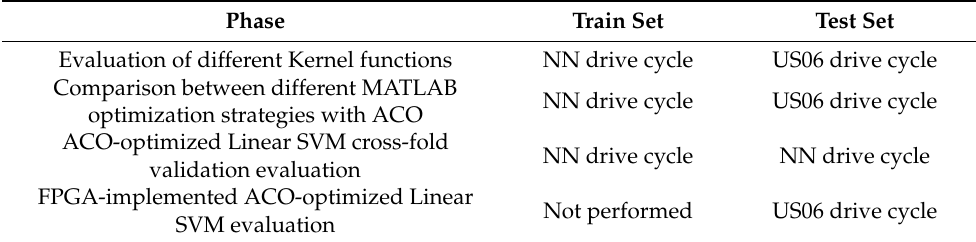
Table 1. Summary of datasets used in each evaluation step, for training and test.